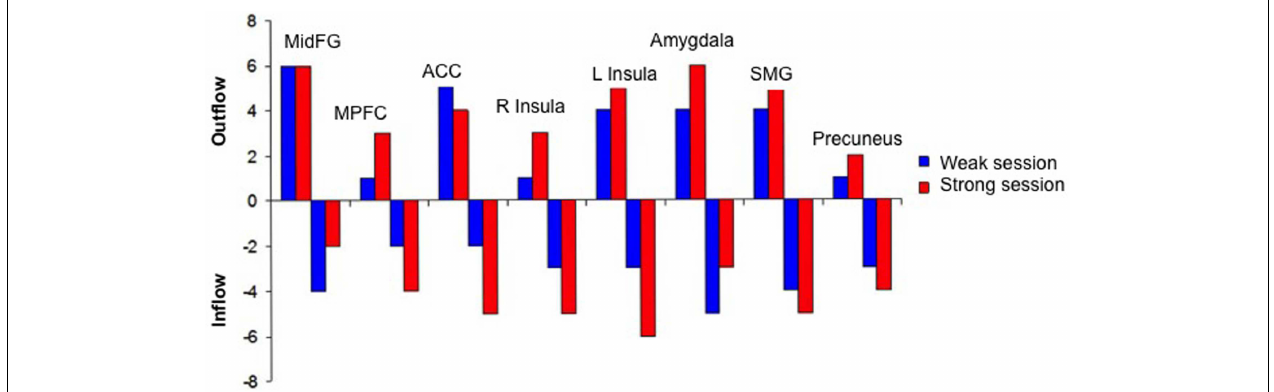
displayed in Figure 5 . MidFG, left middle frontal gyrus; MPFC, left medial prefrontal cortex; ACC, left anterior cingulate cortex; L Insula, left anterior